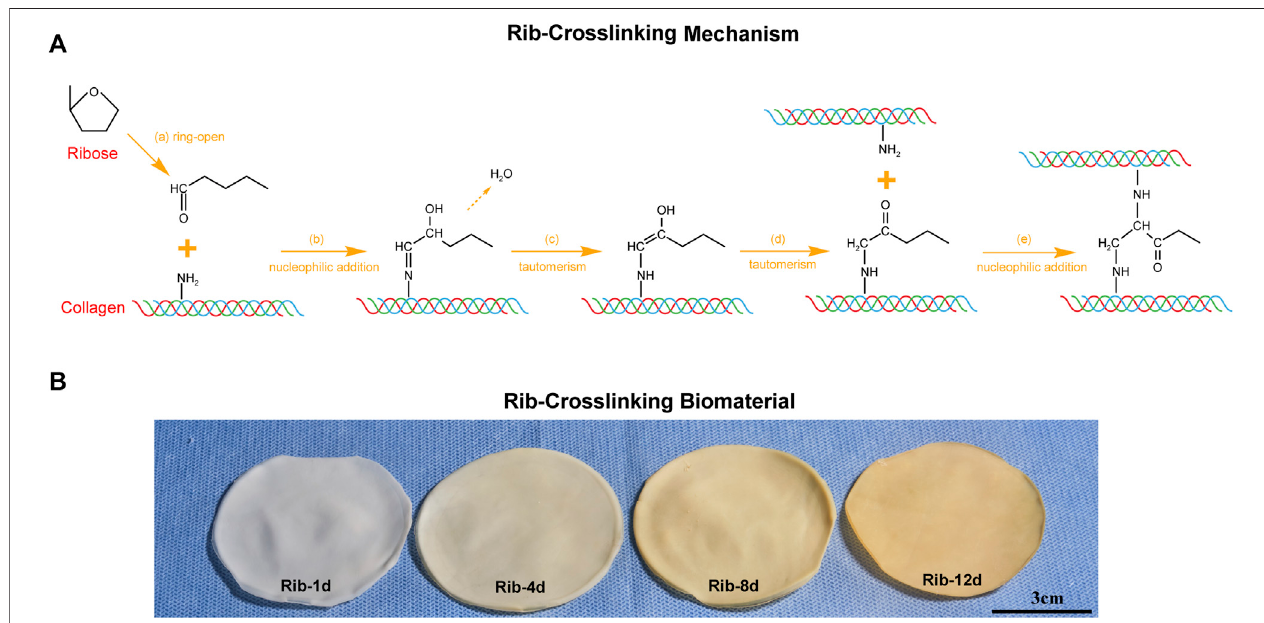
FIGURE 1 | Rib crosslinking method of the bovine pericardium (BP). (A) Schematic illustrations of the mechanism by which Rib stabilizes collagen in the ECM. (B) Effect of Rib crosslinking time on the macroscopic appearance of biomaterials. Scale bars: 3 cm.